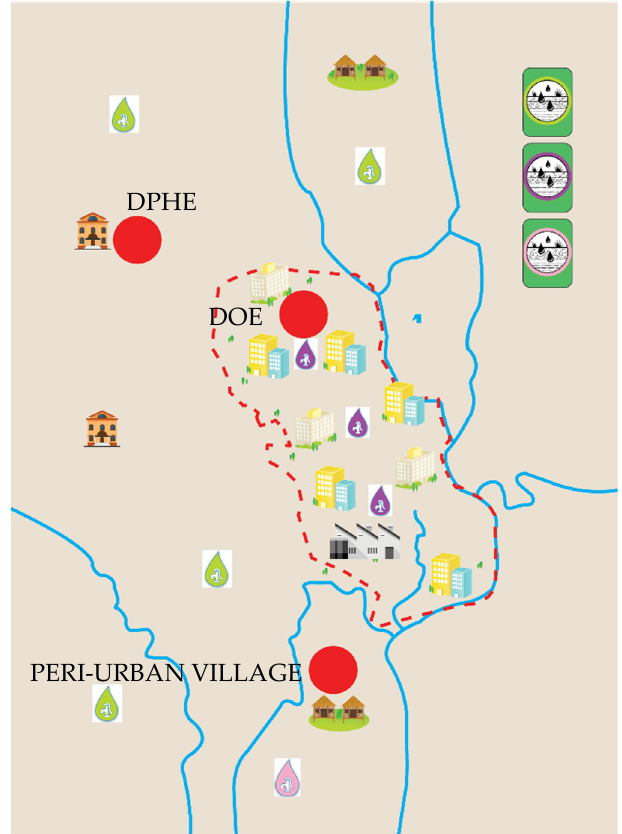
Figure 6. Game play in round 1 (Game 3).